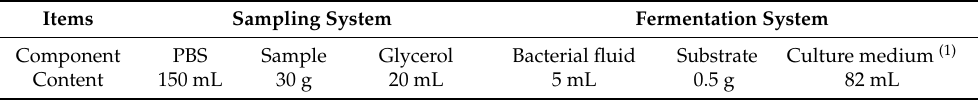
Table 2. The system of sampling and fermentation. Sampling System